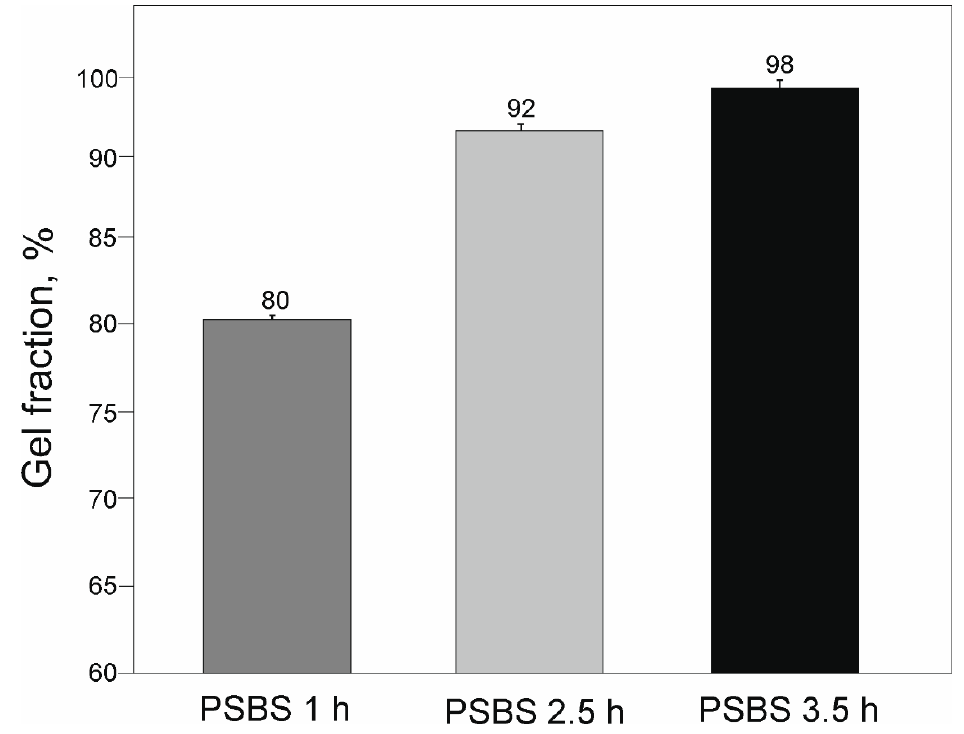
Figure 6. Gel fraction of PSBS 1 h, PSBS 2.5 h and PSBS 3.5 h .